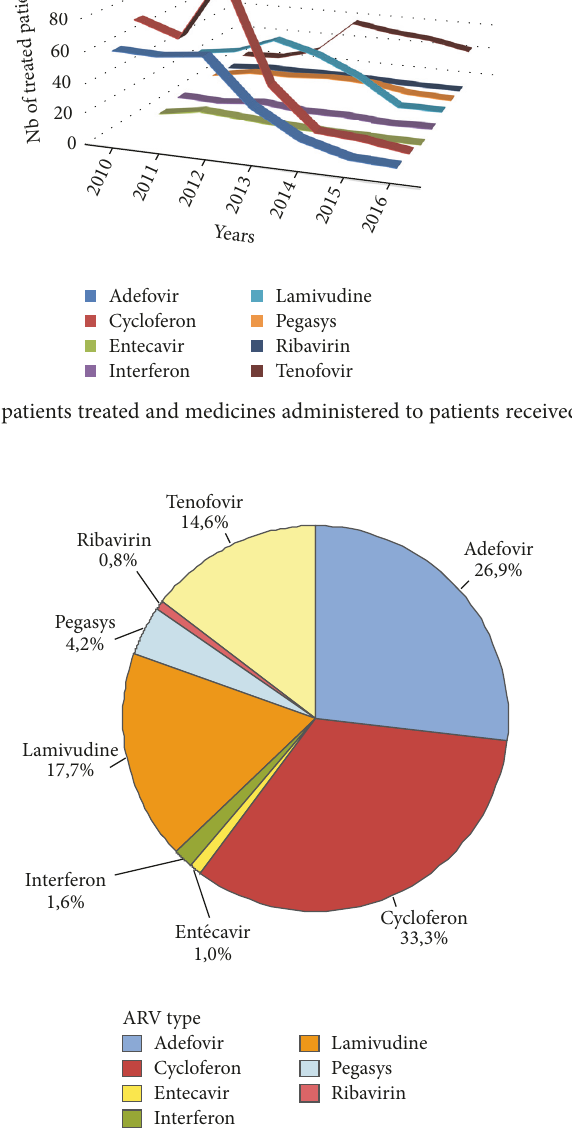
Figure 7: Distribution of drugs (%) used in all therapeutic schemes (single, dual, and